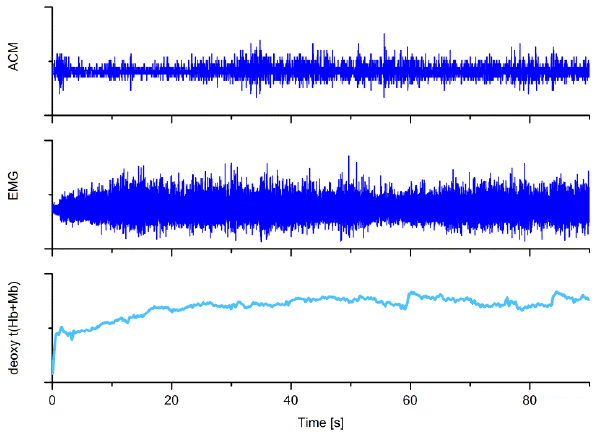
Fig. 6. The response of the second isometric contraction of Subject 4. In the second contraction, Subject 4 could hold up the 5 kg weight only for 90 s whereas in the ¯rst contraction duration was 200 s. We can see that due to the fatigue caused by the ¯rst isometric exercise, the tremor e®ect in ACM as well as in EMG is more present in the second than in the ¯rst iso- metric contraction. Contraction causes increase in deoxy (Hb þ Mb) and °uctuates a little more when fatique starts.